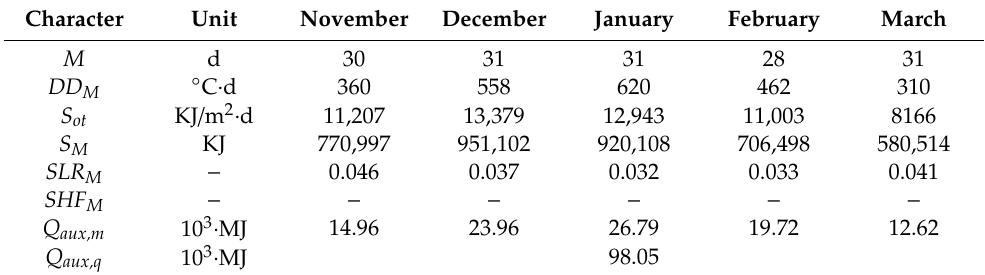
Table 17. Calculation for the yearly auxiliary energy demand in one-story brick-concrete buildings.